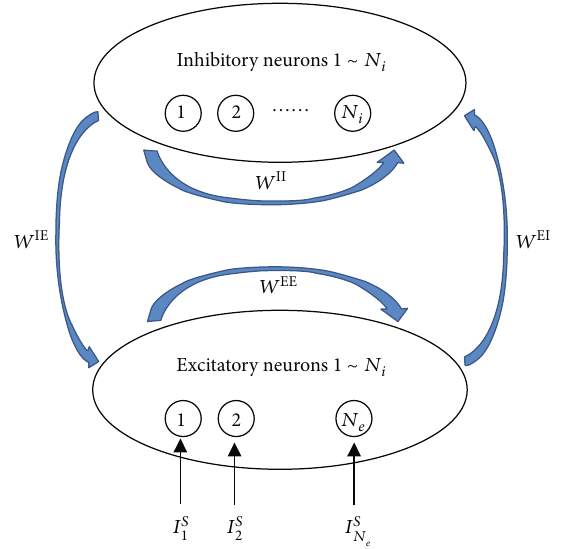
Figure 1: The structure of the E/I